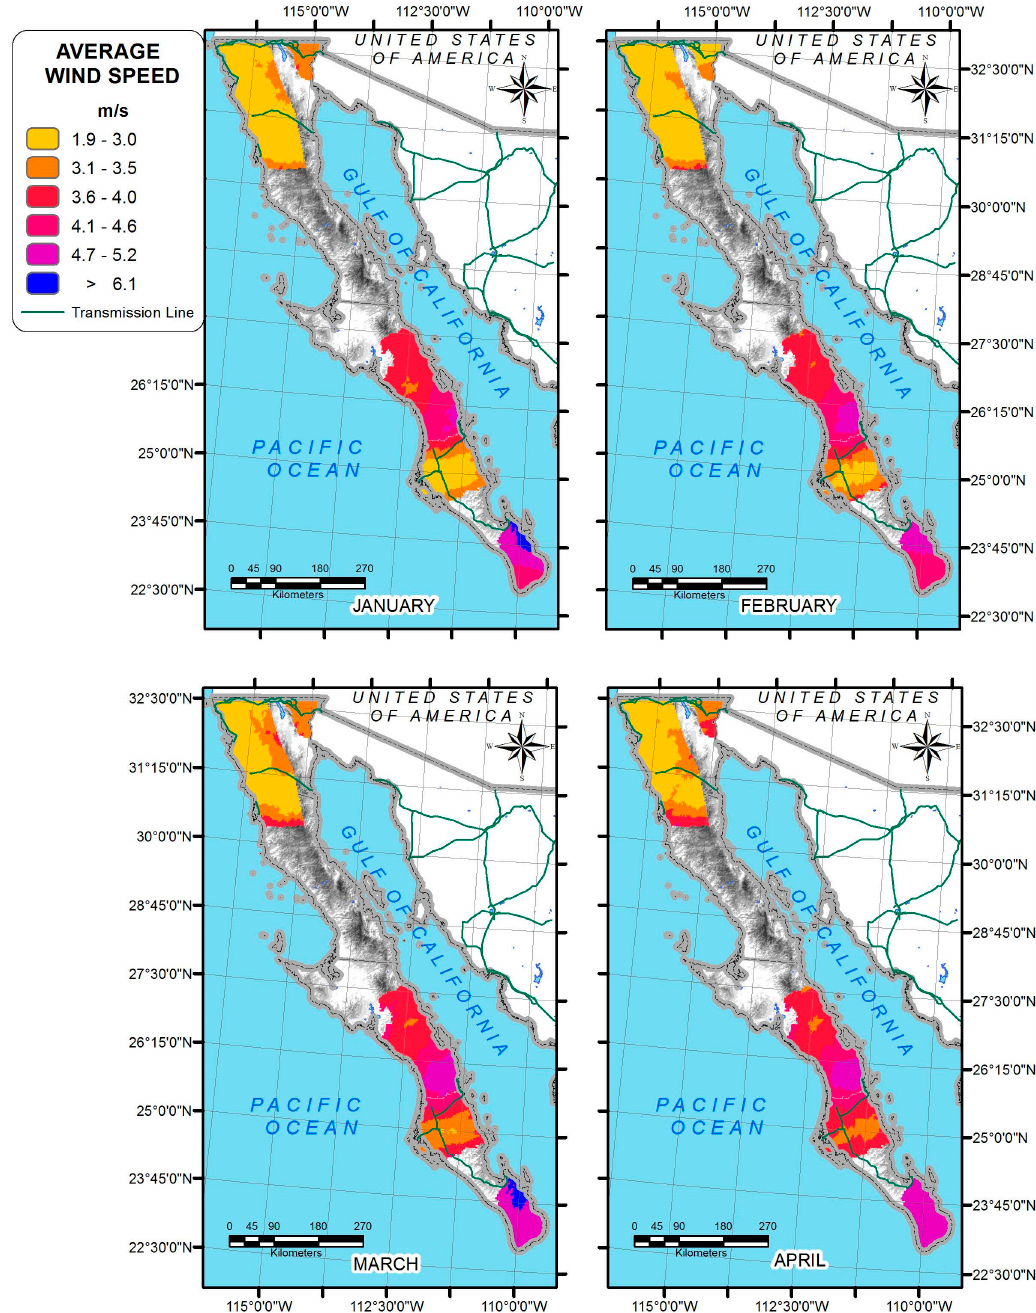
Figure 8. Average wind speed from January to April.